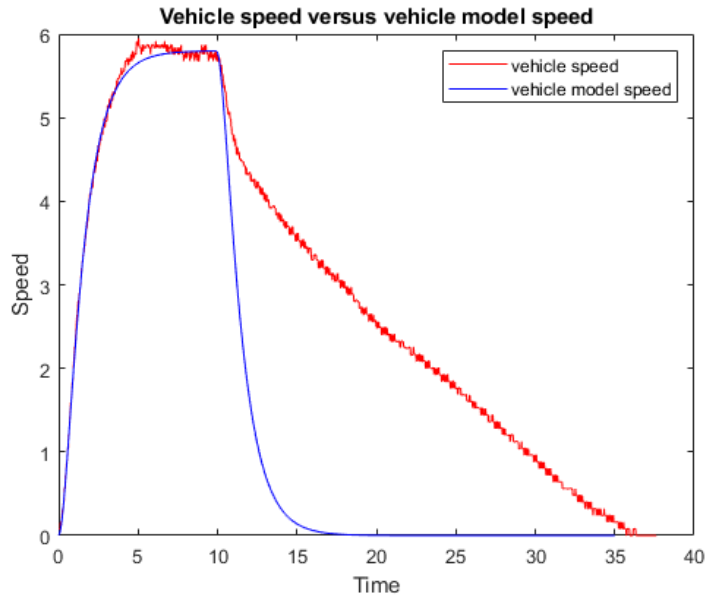
Figure 5. Step response for the electric